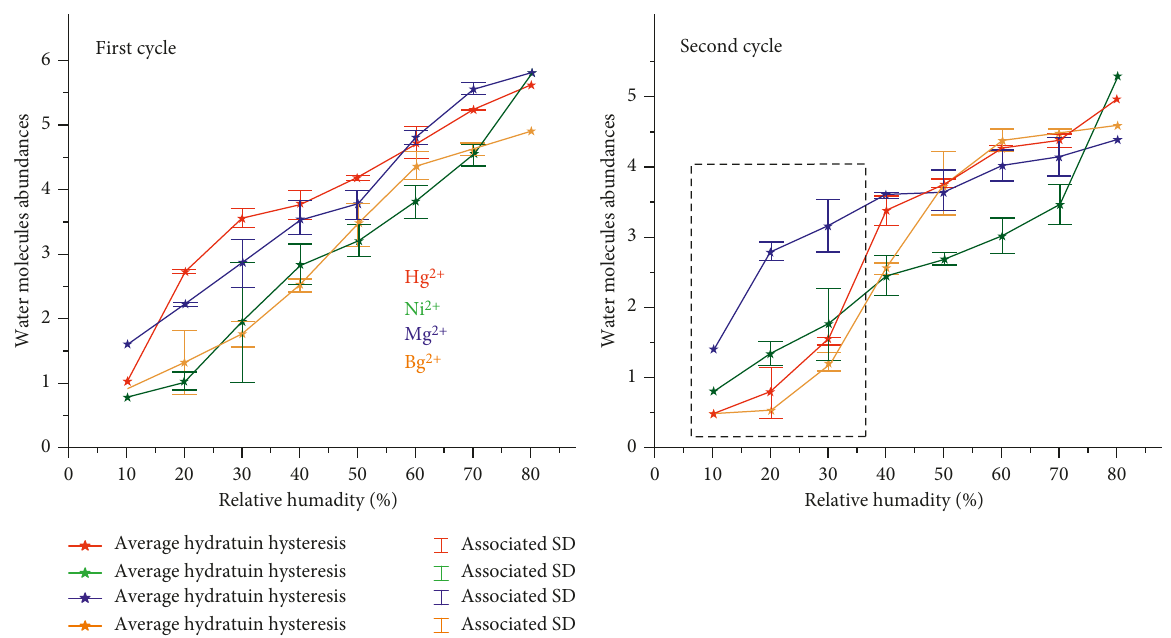
Figure 9: Average hydration hysteresis and the associated SD for the montmorillonite saturated with different bivalent cations in the cases of the first and the second cycles.